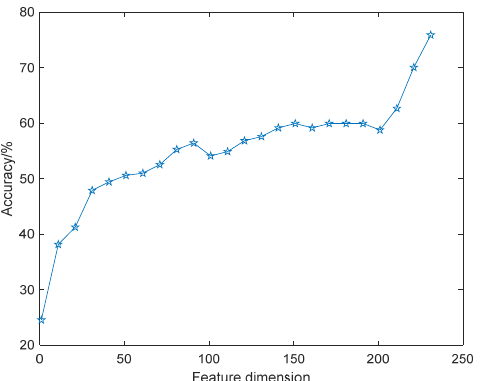
Figure 3. Classification accuracy of original features with feature dimension.